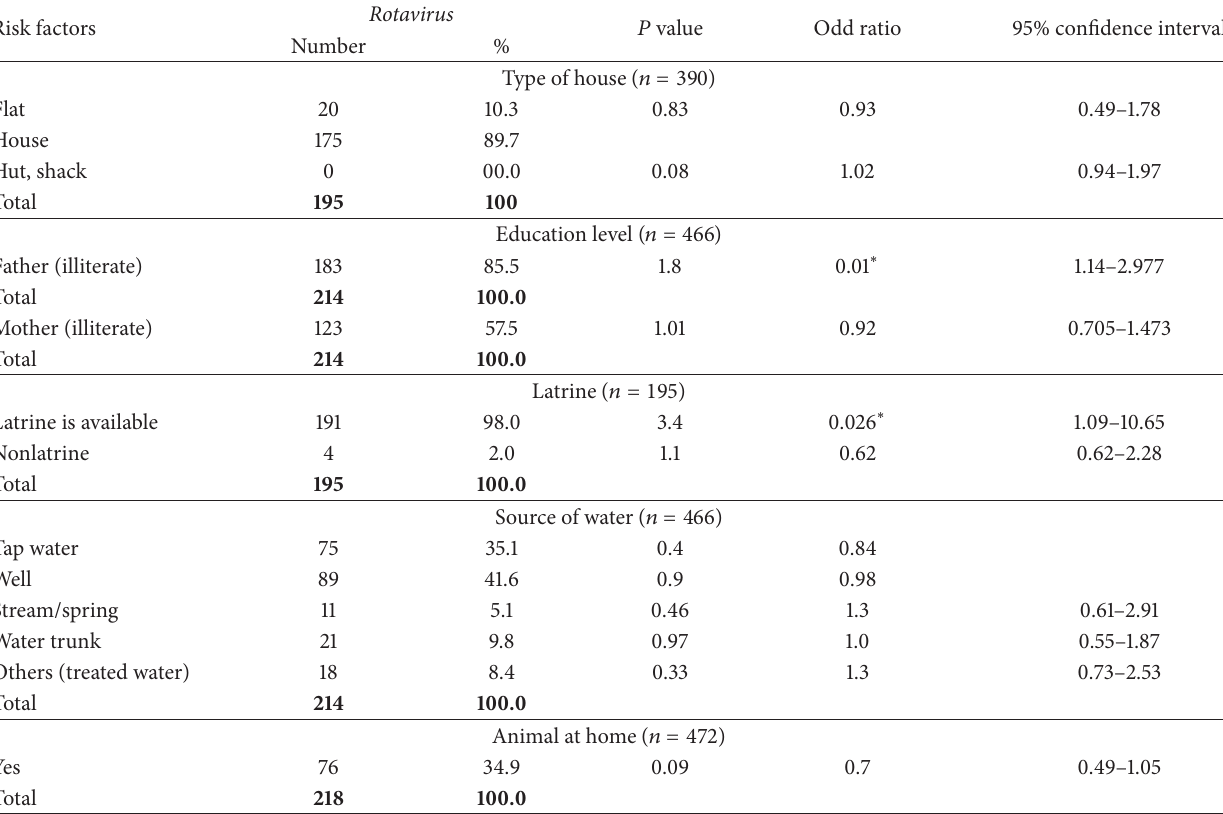
Table 7: Effect of accommodation on outcome of Rotavirus diarrhea among children in Taiz,